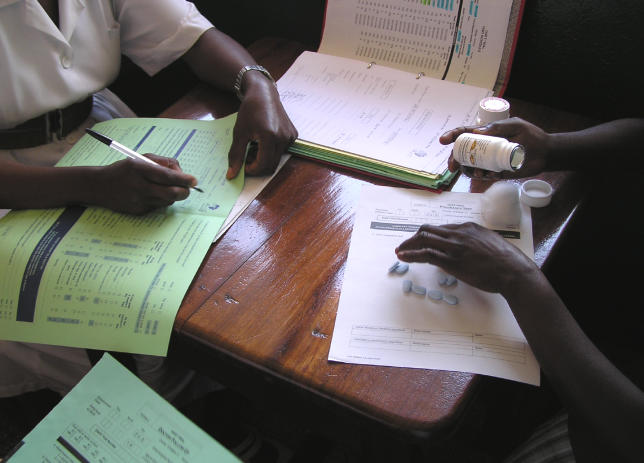
Counting pills during a clinical trial at the Infectious Disease Institute, where the authors are based(Photo: R. Colebunders)